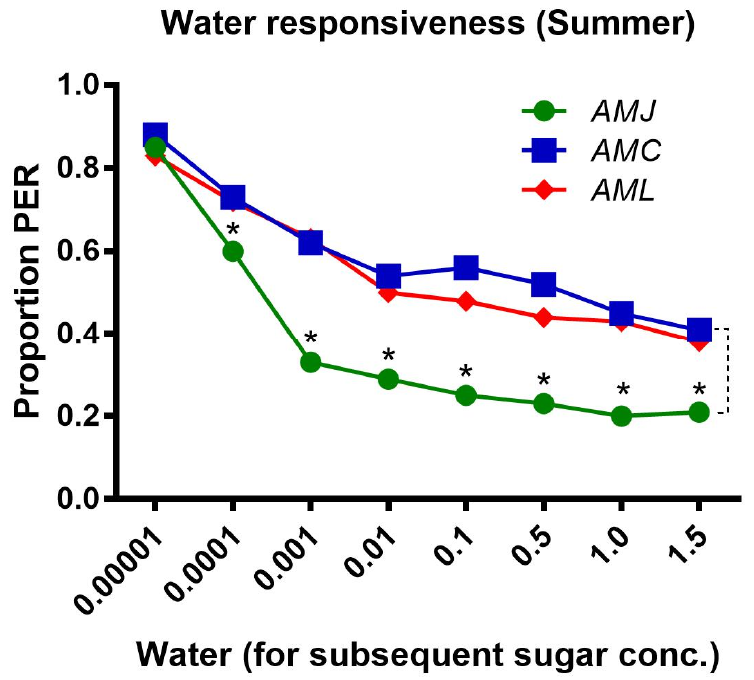
Figure 3. Water responsiveness, i.e., response of bees to water tested prior to the PER test to each sugar concentration. Asterisks indicate the significant difference ( x 2 or Fisher’s exact test * p < 0.05) among the water responses of honey bee subspecies ( AMJ , AMC and AML ).